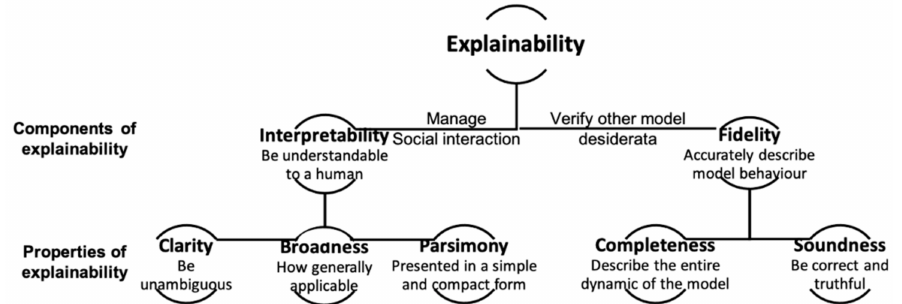
Figure 2. Definition of machine learning (ML) explainability and related properties (adapted from Reference